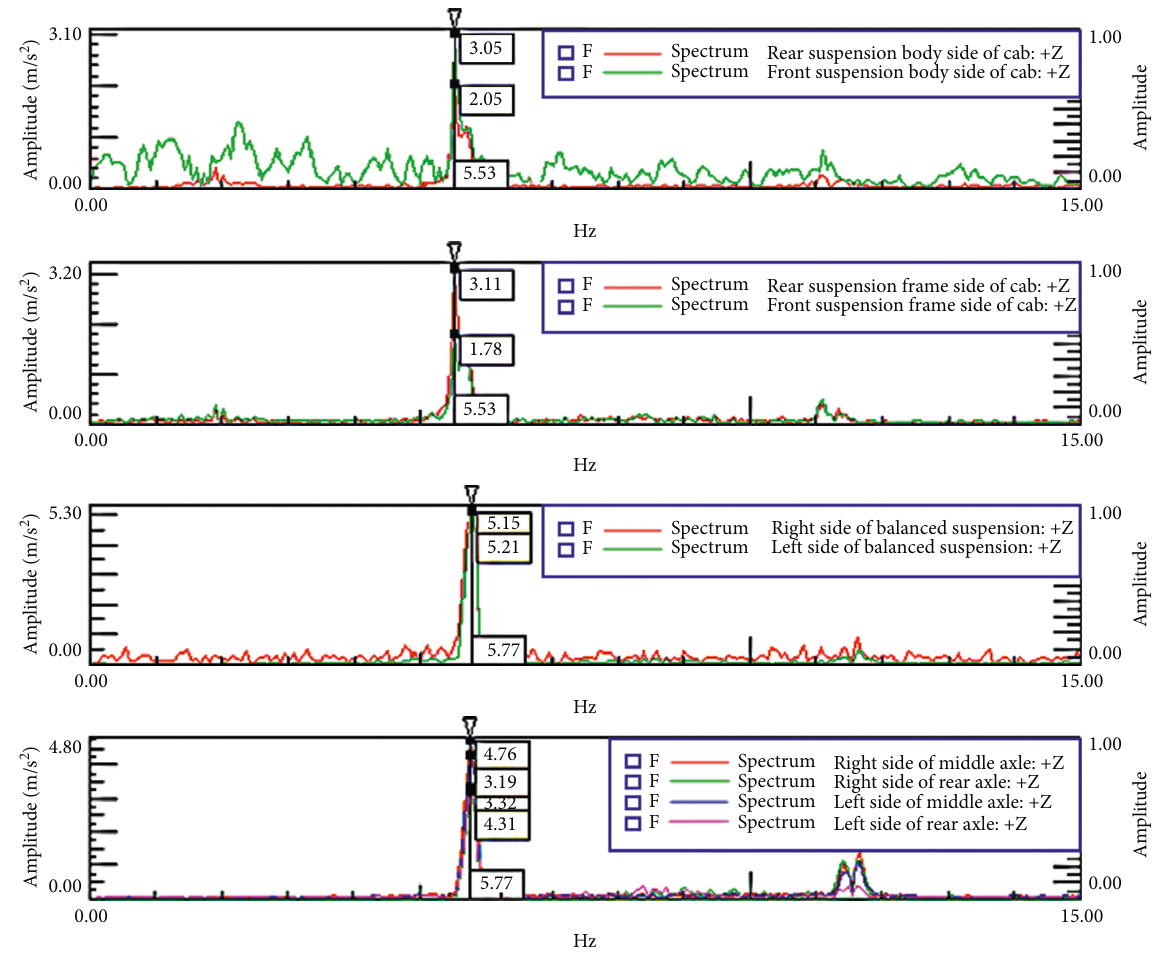
Figure 3: Transmission of vibration acceleration. Table 5: Acceleration (m/s 2 ) on both sides of cab suspension near 65km/h.